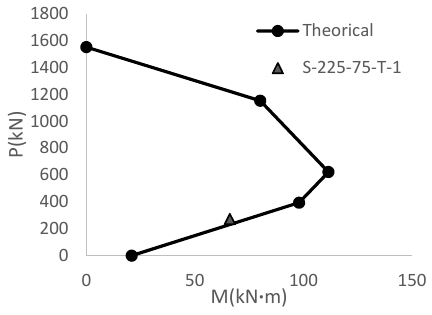
Figure 5. Theoretical interaction curve for the S ‐ 225 ‐ 75 ‐ T ‐ 1 specimen with the experimental P ‐ M pair.